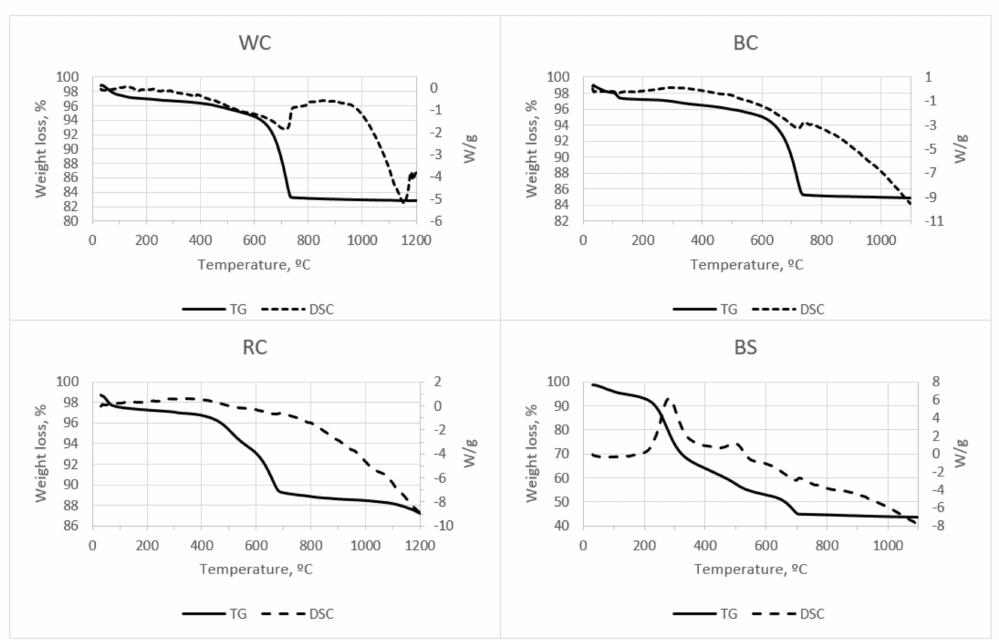
Figure 1. Differential scanning calorimetry and thermogravimetric analysis (DSC-TG) graphs of the clays (white clay (WC), black clay (BC), and red clay (RC)) and wastewater sludge